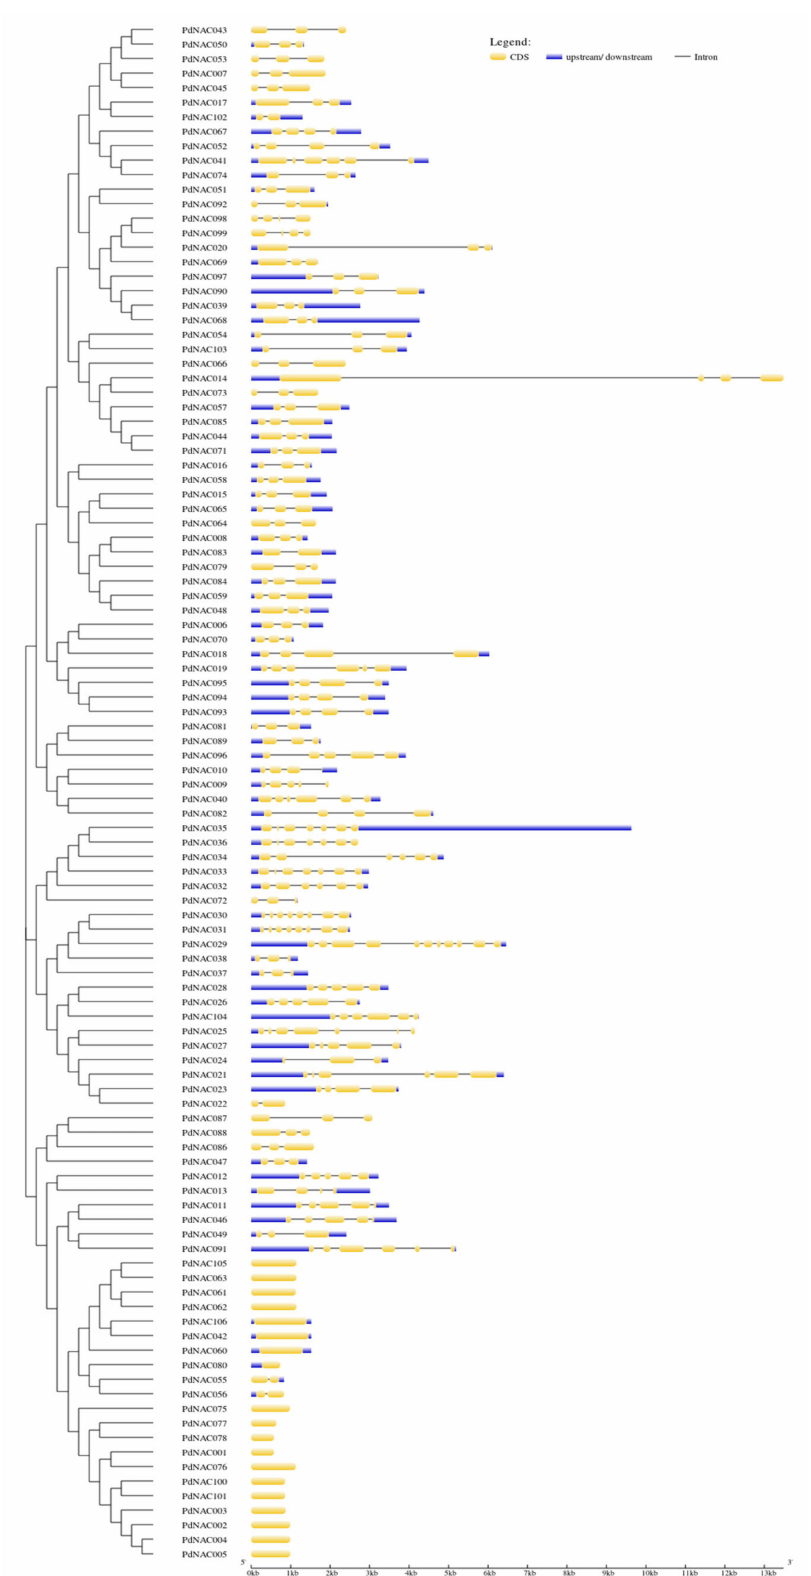
Figure 5. Gene structure prediction of PdNAC genes: Gene structure of PdNAC genes is shown in the figure where CDS, UTRs and intronic regions of the genes are